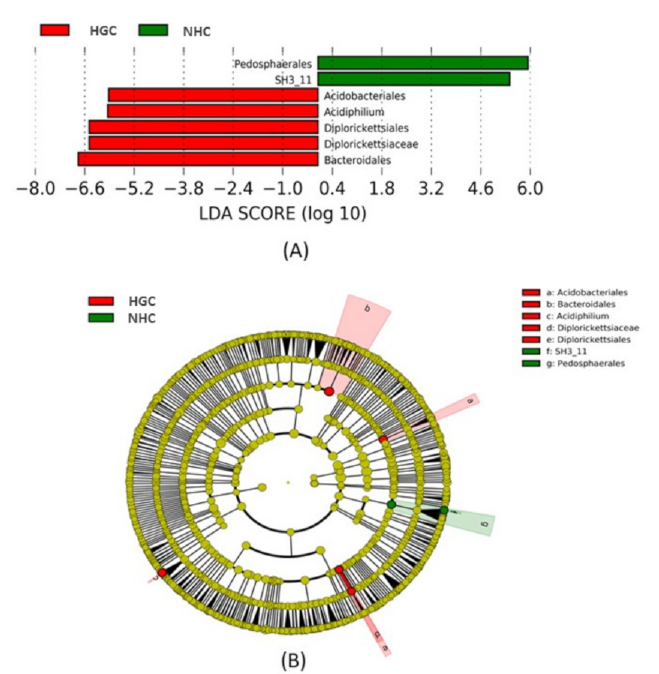
Figure 6. LDA combined with LEfSe showed the abundant bacterial clades. ( A ) Histogram of LDA score between the HGC and NHC samples. ( B ) LEfSe analysis of significant bacterial clades between the HGC and NHC samples.